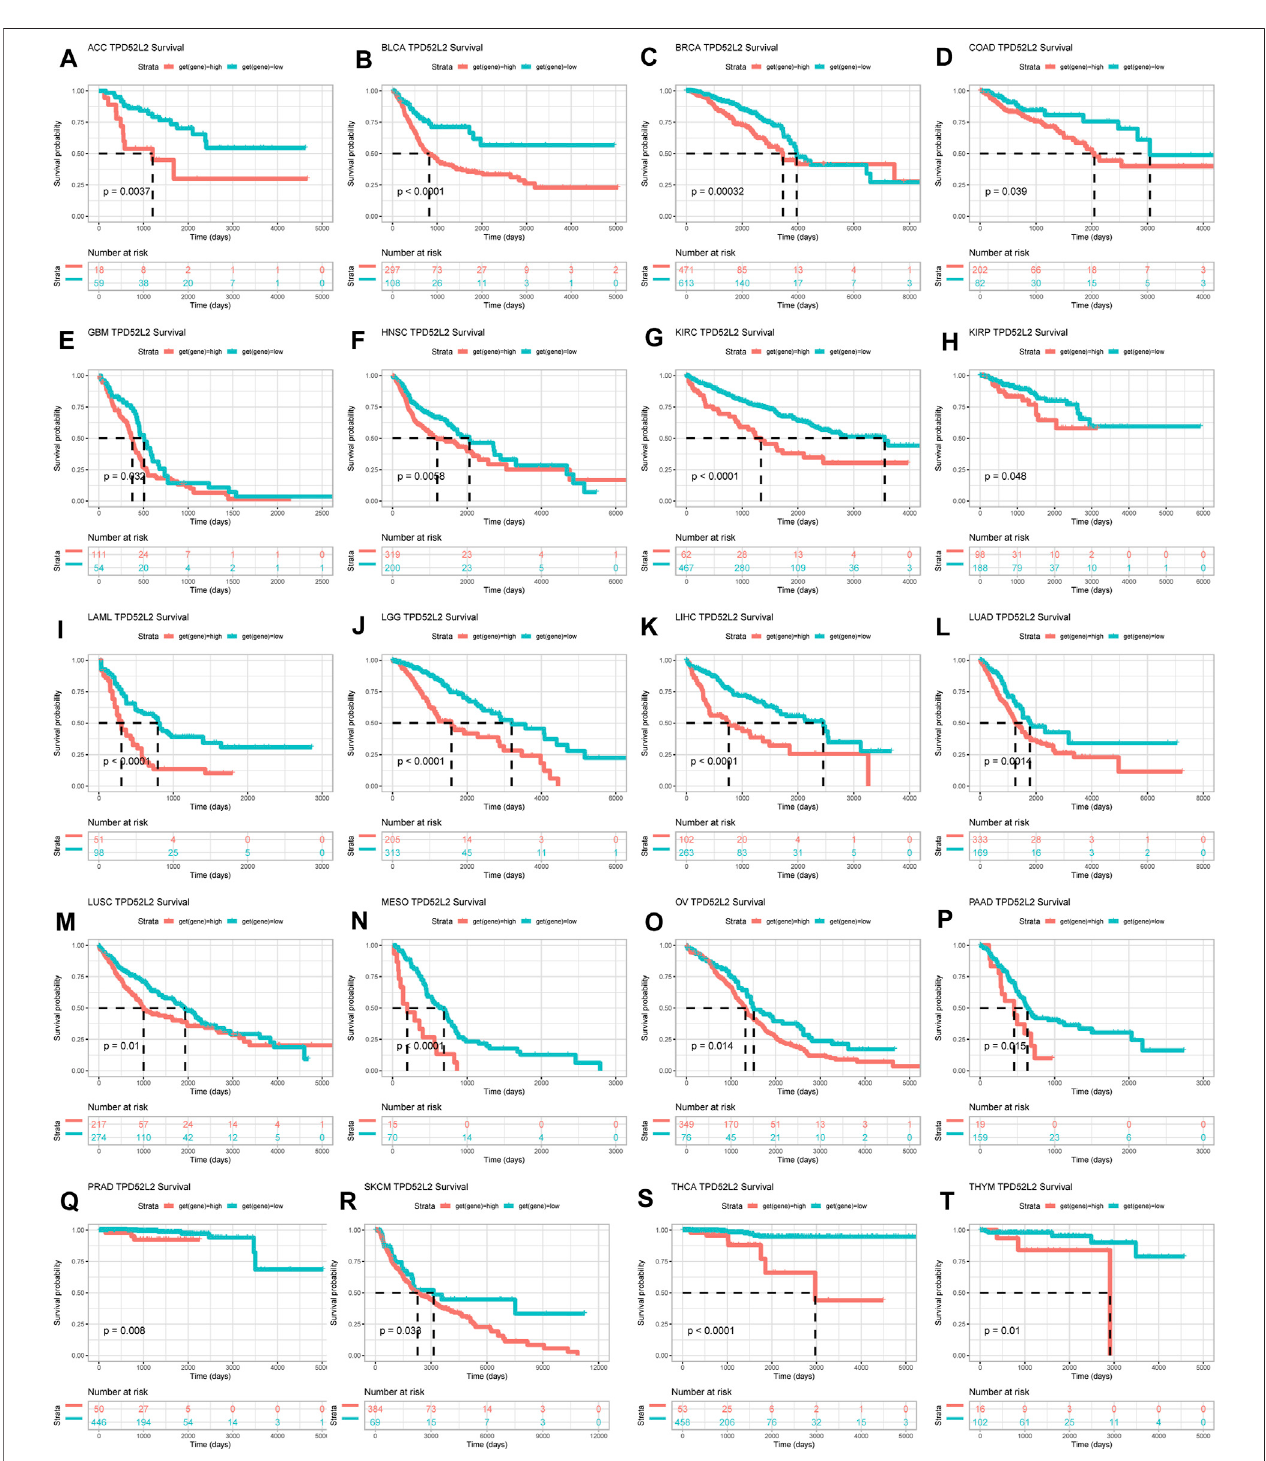
FIGURE 4 | Prognostic signi fi cance of TPD52L2 for OS of patients. (A – T) Kaplan – Meier OS results of TPD52L2 in pan-cancer. The best cutoff of TPD52L2 expression was set as a cut-off value. Only signi fi cant results are shown.